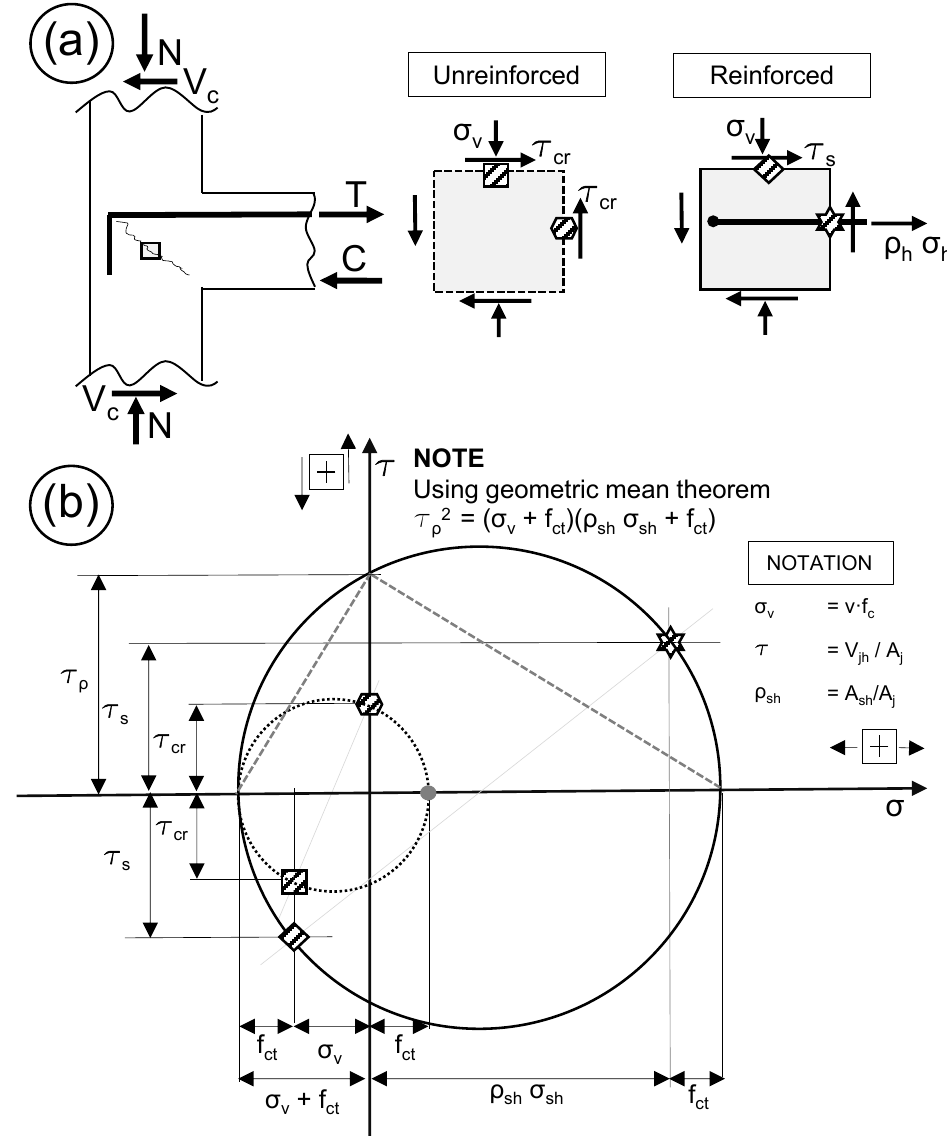
Figure 3. Principal stress method application to beam–column joint: ( a ) Free body diagram and stress state definition for un-reinforced and reinforced joint; ( b ) Mohr’s